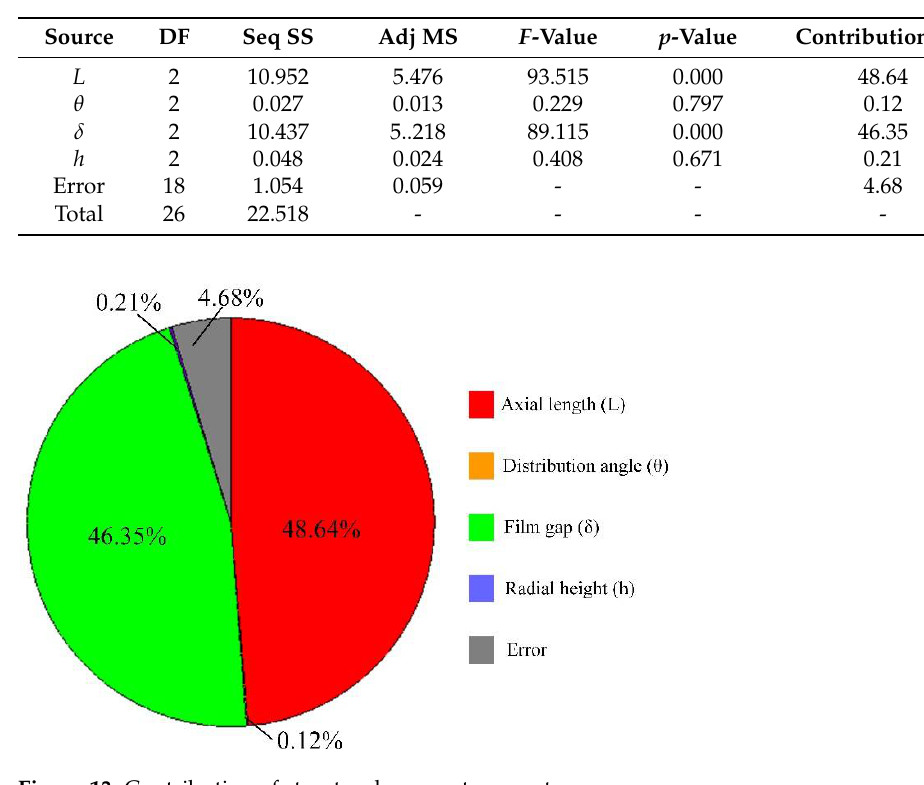
Table 3. ANOVA for stress.